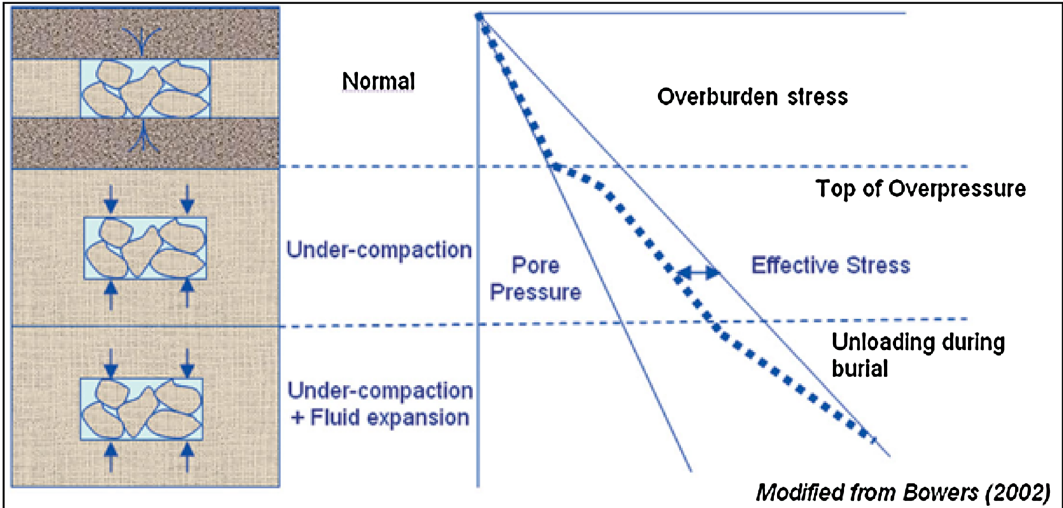
Fig. 1 Effect of vertical effective stress to different subsurface